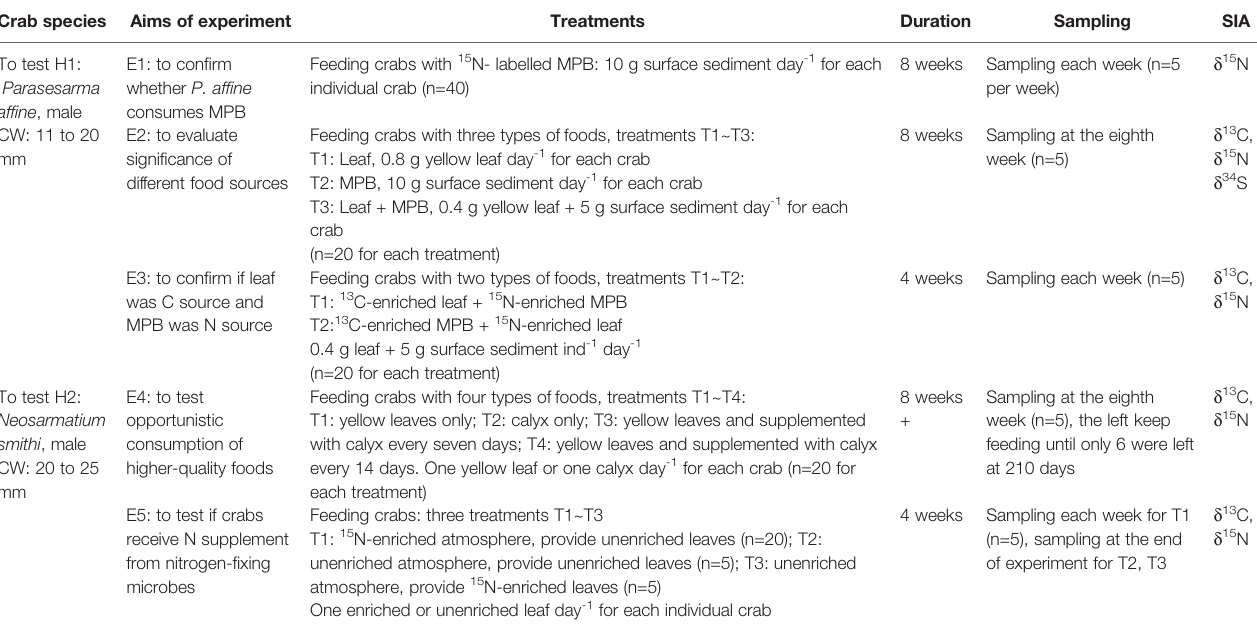
TABLE 1 | Aims and details of the experiments to test hypotheses H1 and H2. CW, carapace width; SIA, stable isotope